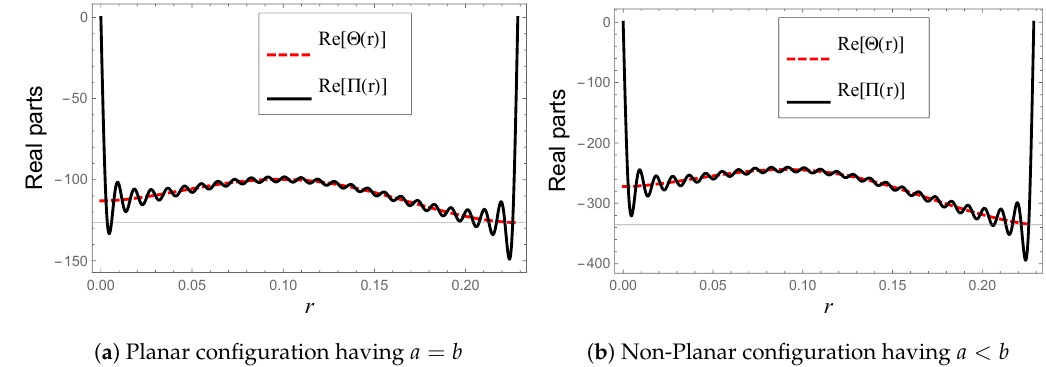
Figure 5. The real parts of Θ ( r ) and Π ( r ) against r .